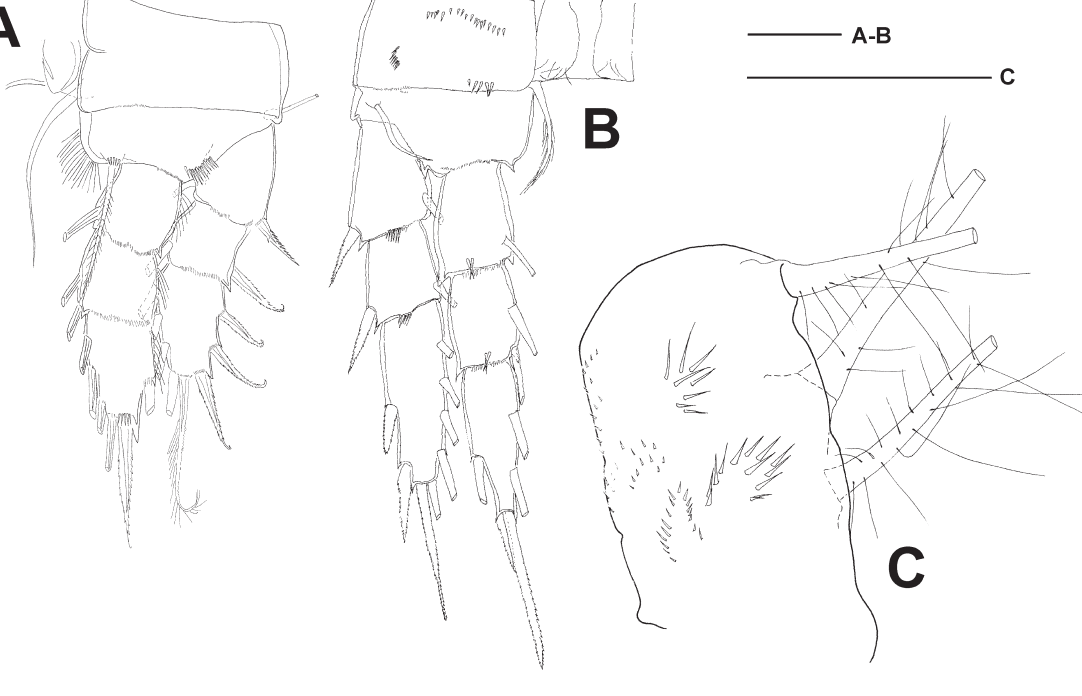
Fig. 9. A−B . Cyclops lacustris G.o. sars, 1863, ♂ (Zmo: sars coll. 12976 ♂-1). A . Leg 1, frontal. B . Leg 4, caudal. C . Cyclops vicinus Uljanin, 1875, maxilliped syncoxopodite, frontal (Lake Østensjøvann, norway − miZ 2/2016/30). scale bars =